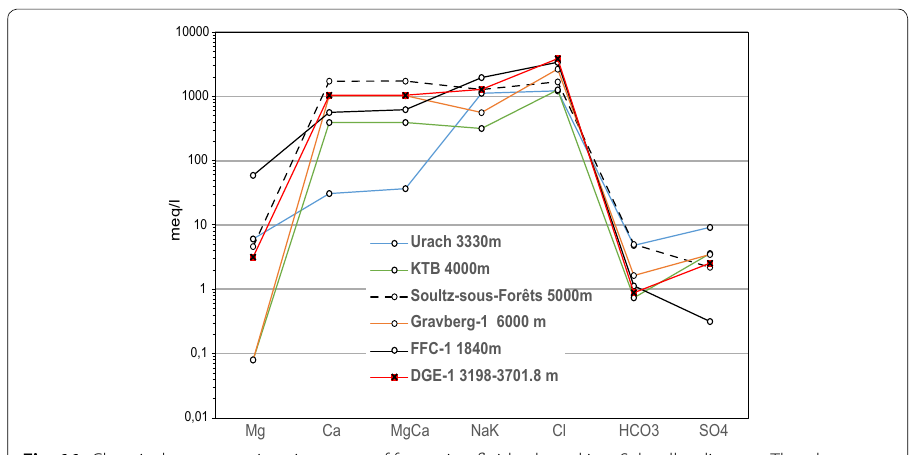
Fig. 11 Chemical concentration signatures of formation fluids plotted in a Schoeller diagram. The plot exemplifies deep boreholes in the upper crystalline crust, i.e., Urach (Stober and Bucher 2004), KTB (Stober and Bucher 2005), Soultz‑sous‑Forêts (Pauwels et al. 1993, Sanjuan et al. 2006), Gravberg‑1 (Aldahan et al. 1991), and DGE‑1. The FFC‑1 data represent fluids coming in the Triassic succession at 1840 m depth in southwest Skåne (DONG